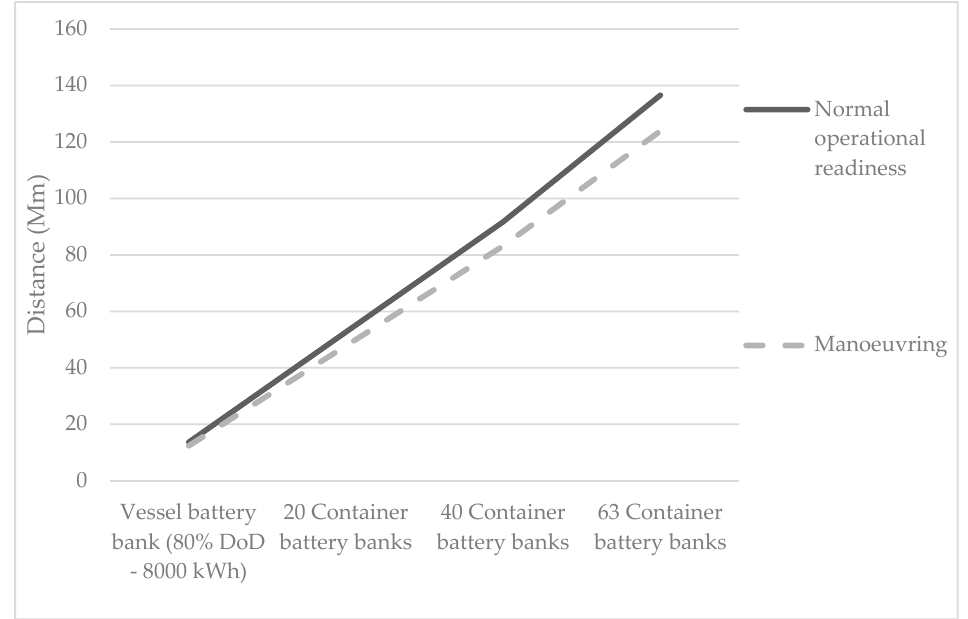
Figure 11. Operation range of the vessel as a function of the number of container battery banks.